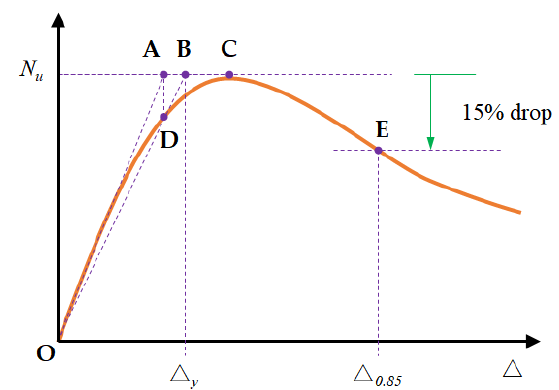
Figure 12. Definitions of yield displacement ∆ y and ultimate displacement ∆ 0.85 .